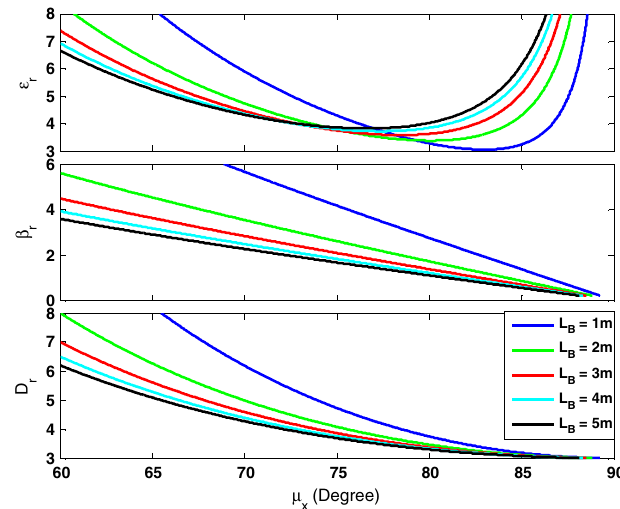
FIG. 7. Parameter scaling curves in modified-TME lattice with different dipole